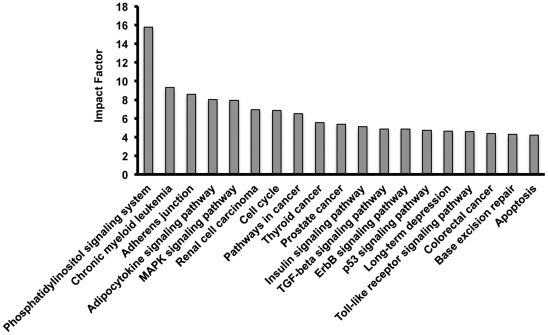
Pathway analysis of genes differentially expressed in siPax8 vs. controls.Pathway-Express software was used to identify the pathways most affected by the gene dysregulation. The histograms represent affected pathways ranked according to the impact factor, an index that measures the pathway perturbation [56].